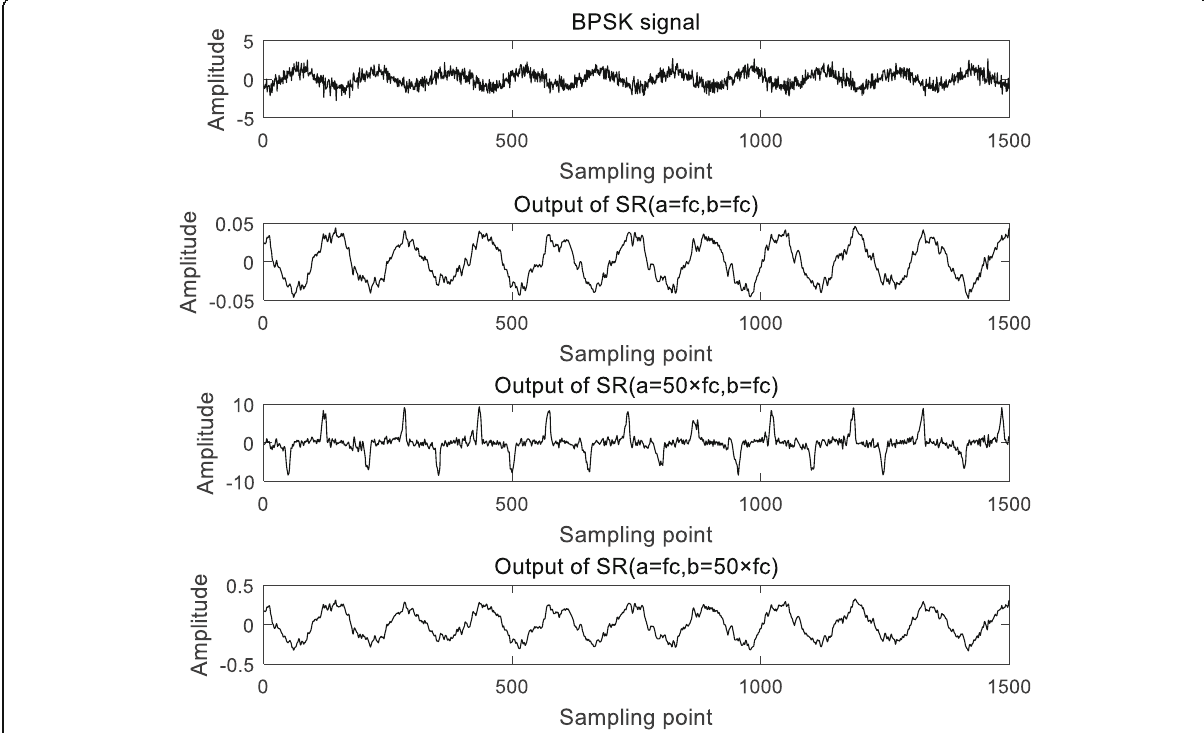
Fig. 5 Effect of different system parameters on the stochastic resonance output